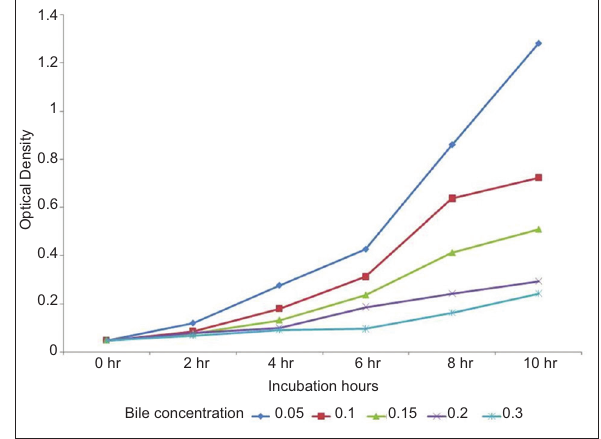
Figure-3: Optical density of de Man Rogosa Sharpe medium containing Lactobacillus plantarum at various bile concentrations measured at 2 hourly intervals at 650 nm.